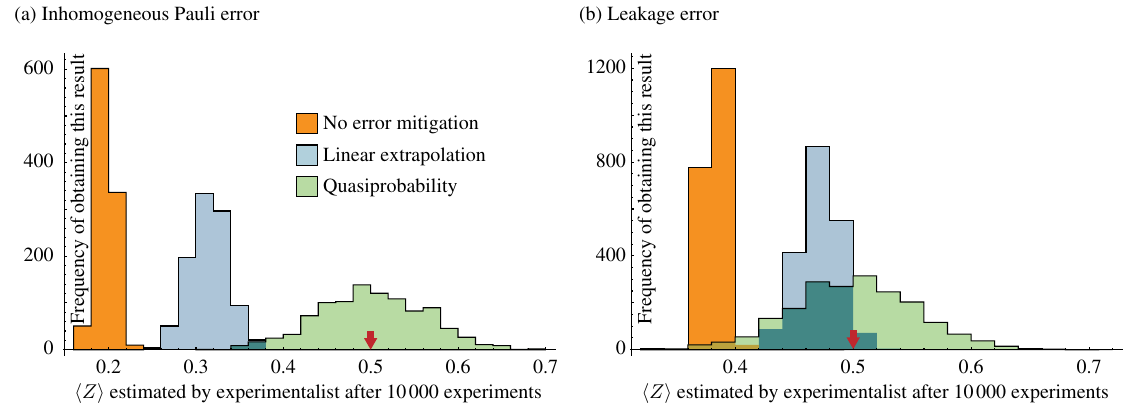
FIG. 5. Histograms of the estimation of h Z i using quantum computers with inhomogeneous Pauli error and leakage error. For the inhomogeneous Pauli error model, the SWAP -test circuit involving 19 qubits is simulated: one qubit is the probe qubit, and each group has 9 qubits. For the leakage error model, the SWAP -test circuit involving fewer qubits (15 qubits) is simulated, because in the numerical simulation we need to use an additional qubit to introduce the leakage process. The ideal value of h Z i is marked by the red